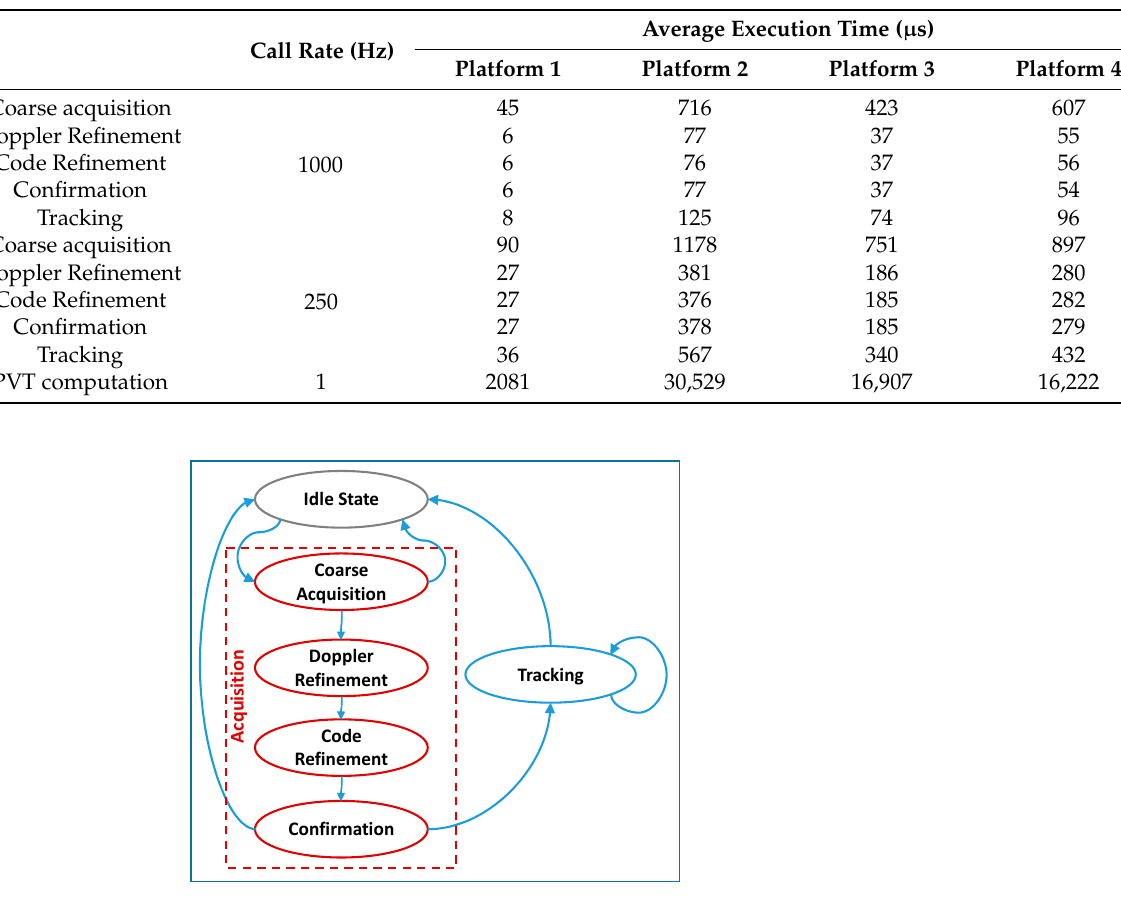
Table 9. Call rate and average execution time of the main receiver processing steps, configured to elaborate 12 satellites, i.e., 6 GPS and 6 Galileo.